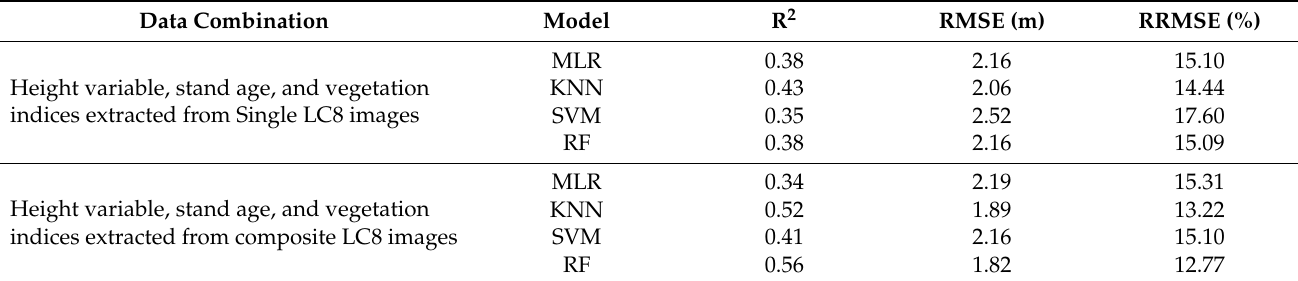
Table 2. The results of corrected CHM.